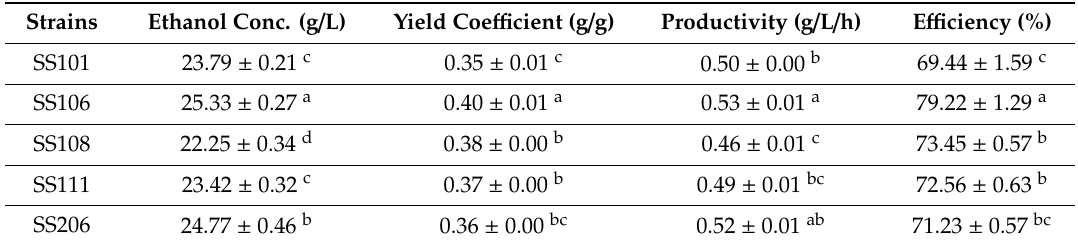
Table 1. Comparison of the kinetic parameters of selected yeast stains after 48 h of fermentation in fermentation medium composed of 200 g / L of glucose at 40 ◦ C.